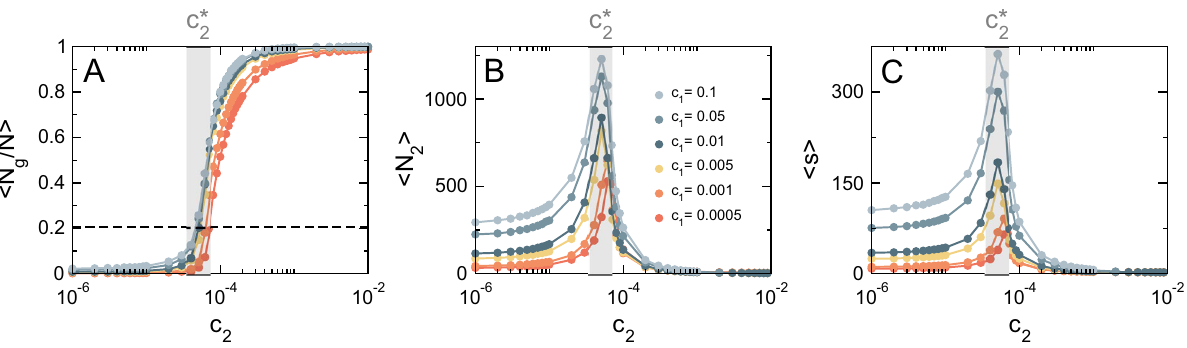
Figure 3. Phase transition in the AB model. ( A ) Order parameter (cid:31) N g / N (cid:30) as a function of the control 4 parameter c 2 for a system of size N e = 1.5 × 10 and different values of c 1 . Shaded region depicts the pseudo– critical value c ∗ 2 for c 1 = 0.01 . Dashed line denotes the proportion of nodes belonging to the largest cluster at the critical point for c 1 = 0.01 . ( B ) Size of the second largest cluster (cid:31) N 2 (cid:30) as a function of c 2 . ( C ) Susceptibility (cid:31) s (cid:30) as a function of c 2